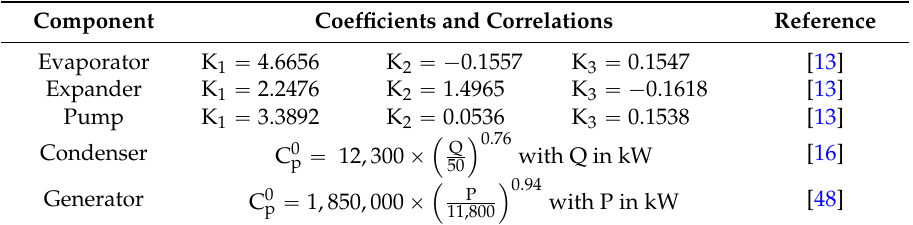
Table 3. Coefficients and correlations for estimation of the purchased equipment costs.